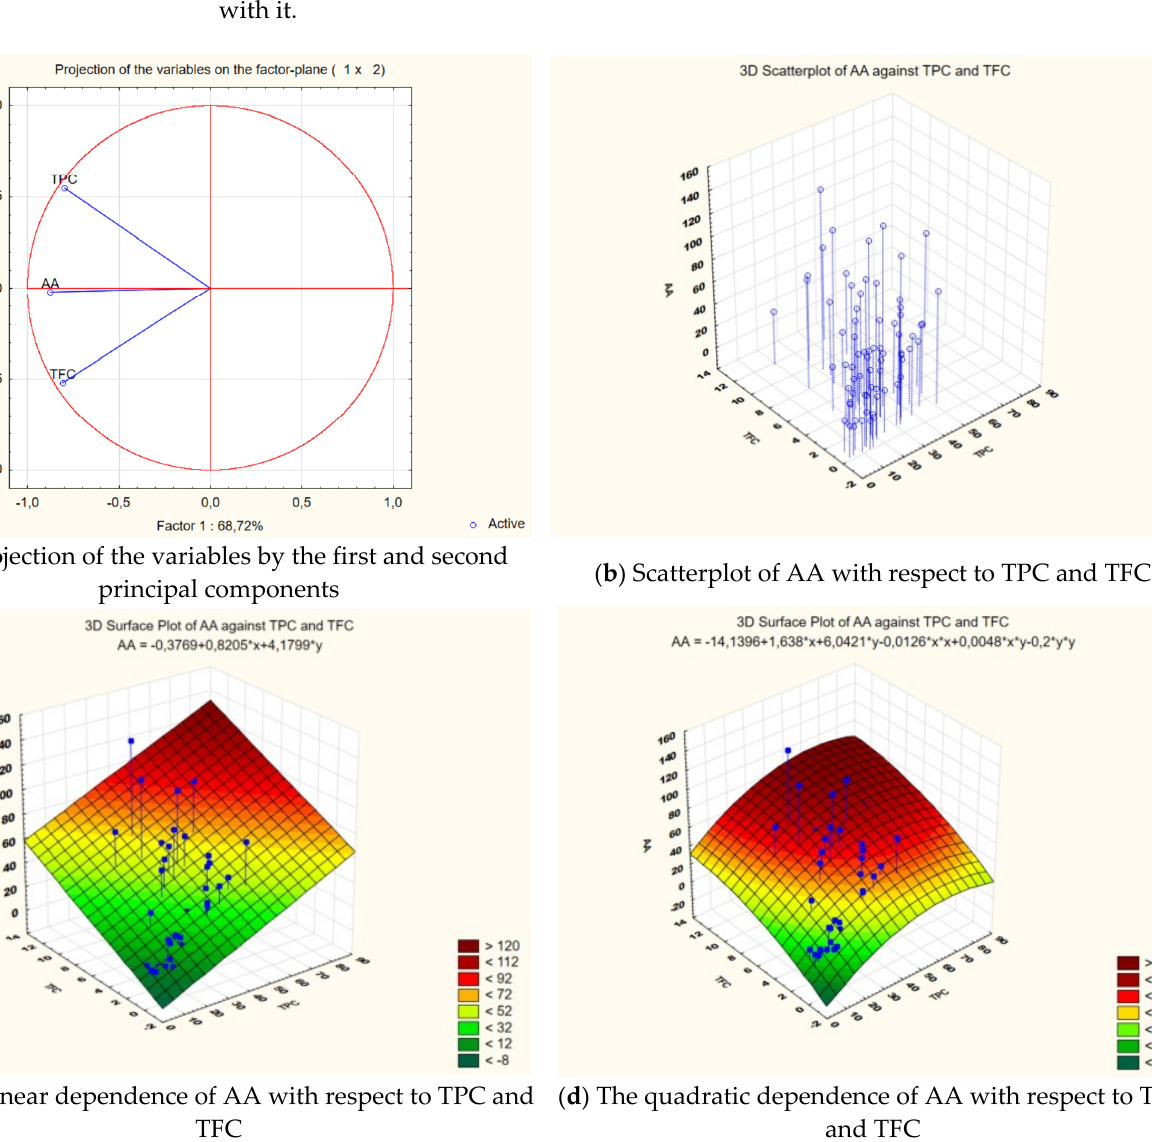
Figure 8. Linear correlations between AA, TPC, and TFC; linear and quadratic dependence of AA with respect to TPC and TFC.